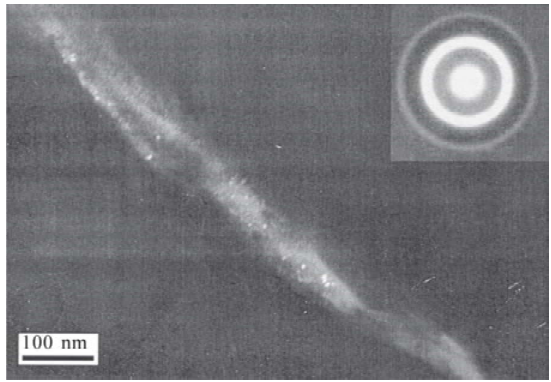
Fig. 8. Electron microscopic image of the crystal- lized local shear band in the Ni amorphous alloys after severe plastic deforma- tion ( n = 0.5; T =